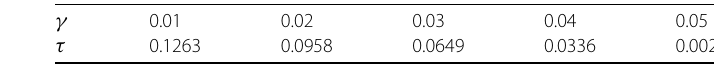
Table 1 The allowed upper bound τ for different γ